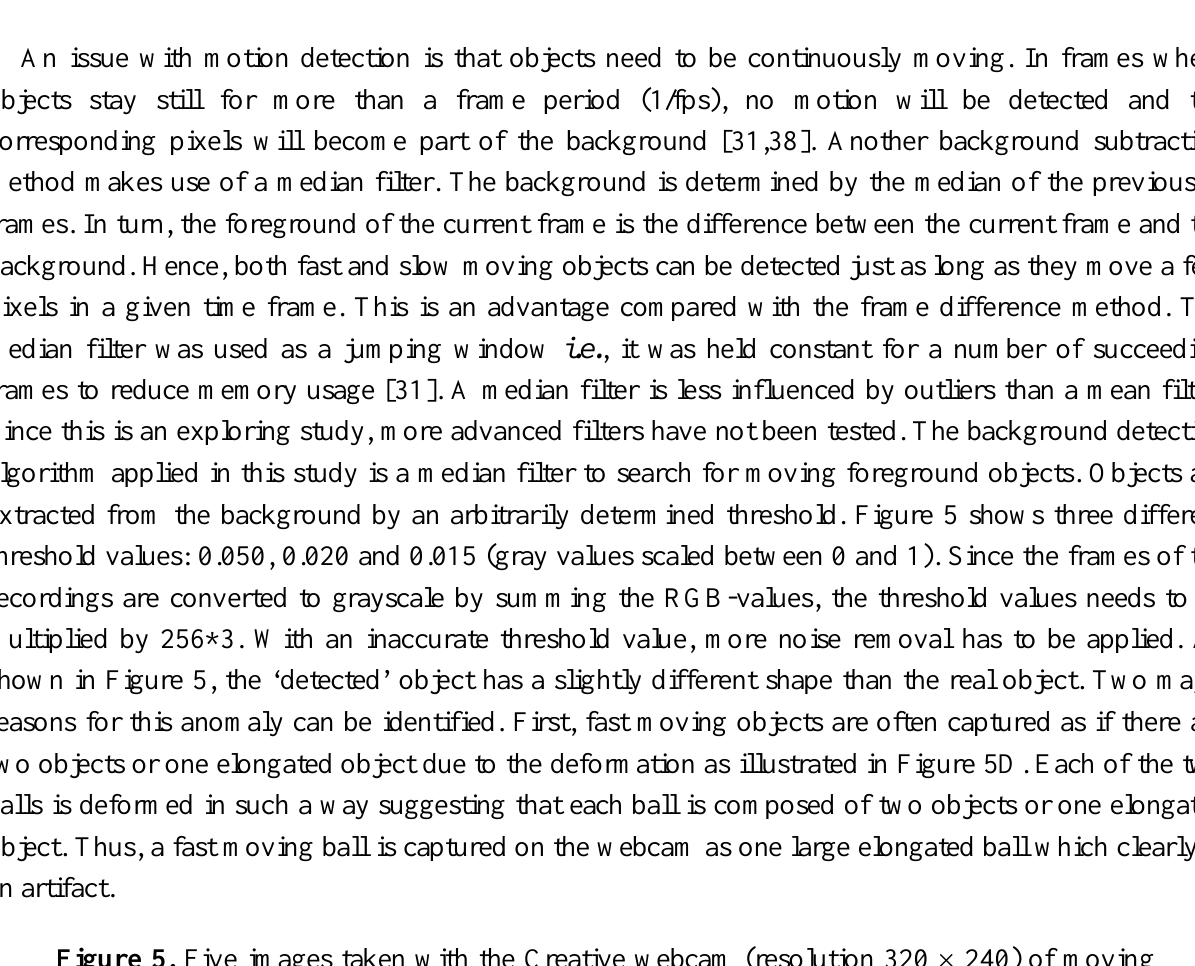
Figure 5. Five images taken with the Creative webcam (resolution 320 × 240) of moving balls on a floor. Images (A), (B) and (C) illustrate a background subtraction with threshold values of 0.050, 0.020 and 0.015, respectively which causes noise. The large white objects are the moving target objects. Noisy pixels are not retained by the threshold and appear as white flecks. Without the noise removal these pixels are falsely classified as moving objects. (D) Deformed object. (E) Overlay of 2 succeeding